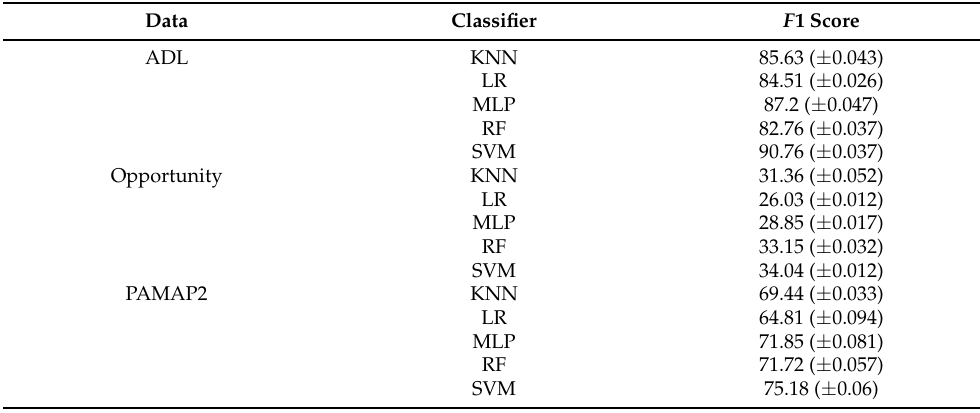
Table A2. Comparing the performance of the baseline classifiers on multiple datasets. The reported mean of F 1 scores and ( ± standard deviation) were obtained from 30 repetitions. The F 1 score is as %.